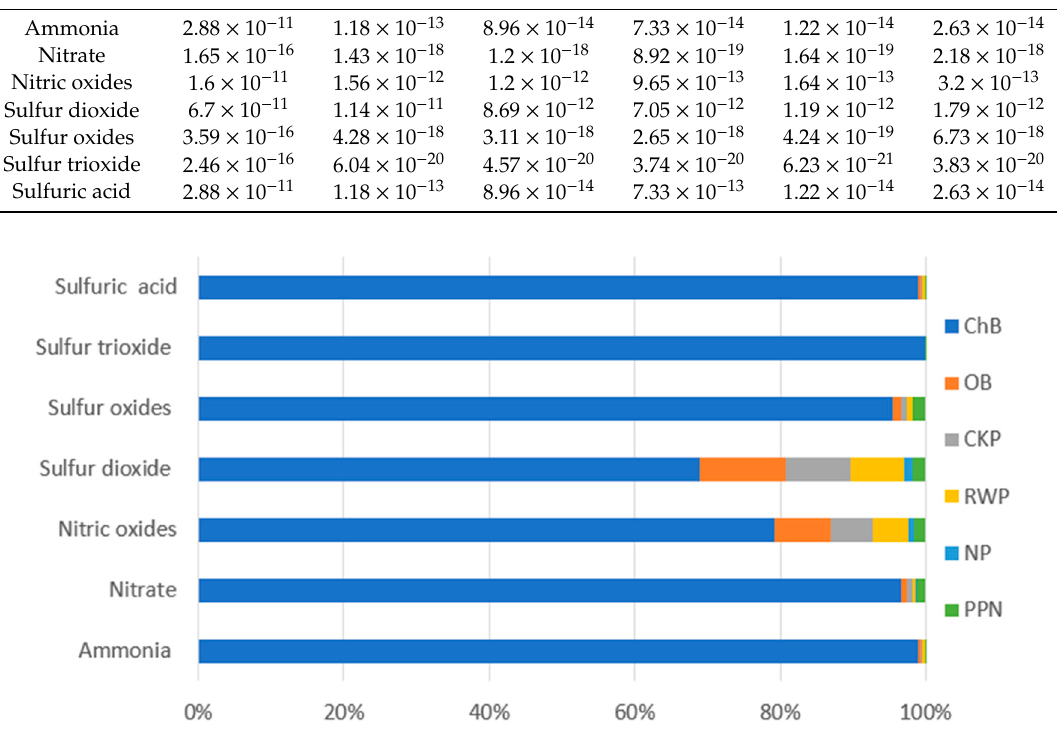
Figure 12. Results of environmental impact characterization for the category of land acidification (species.yr).